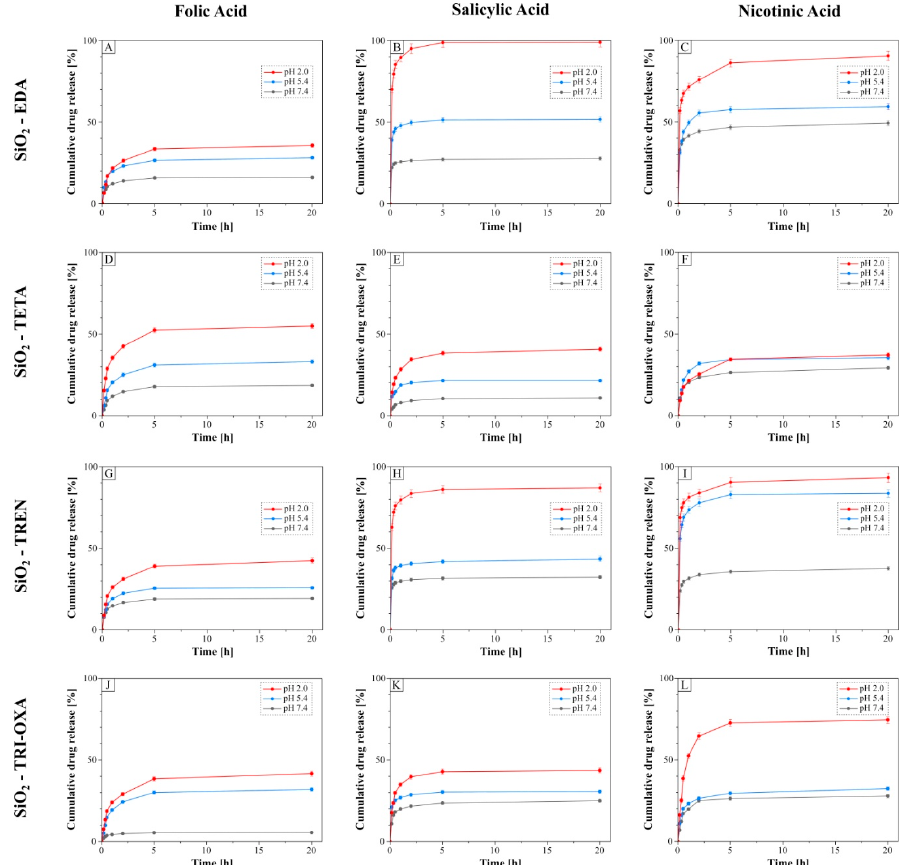
Figure 6. Release profiles of the biocompounds (folic acid: A, D, G, J ; salicylic acid: B, E, H, K ; nicotinic acid: C, F, I, L ) from the drug-loaded hybrid materials: SiO 2 -EDA ( A – C ); SiO 2 -TETA ( D – F ), SiO 2